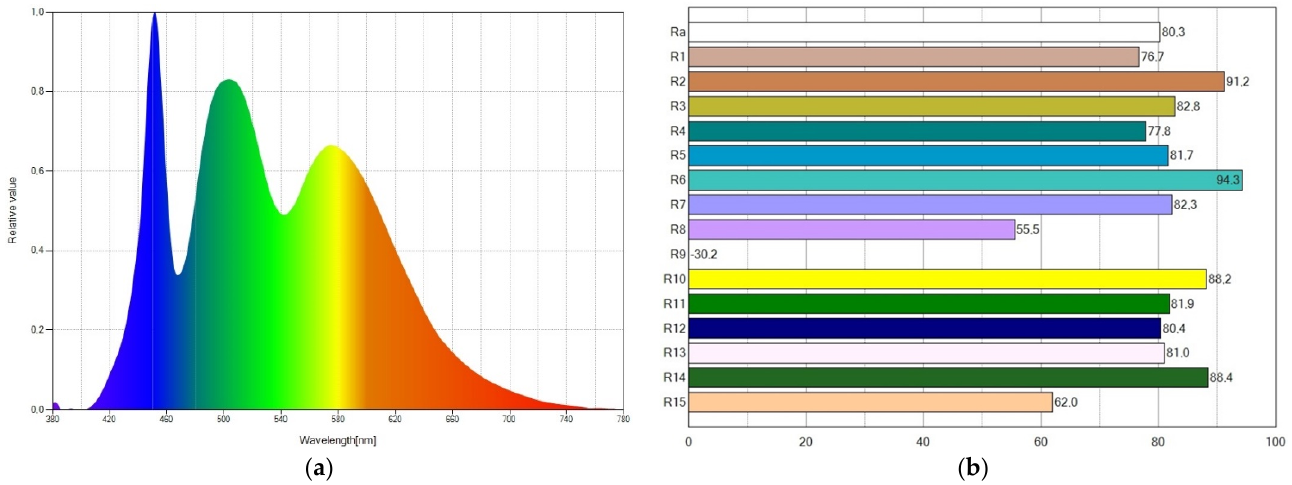
Figure 3. For WLED16, ( a ) spectral power distribution showing a high blue peak and ( b ) CRI values reaching a CRI (R a ) value of 80.3.